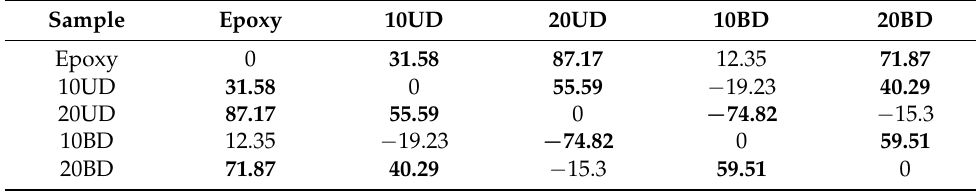
Table 2. Tukey test for the Izod impact test absorbed energy values.